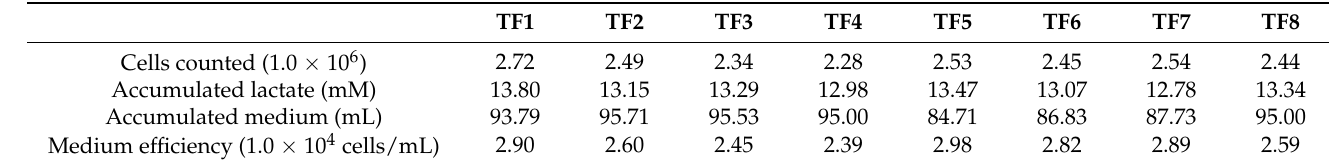
Table 6. Cell expansion results from the second controller experiment. Number of cells counted, total amount of accumulated lactate produced (mM), total amount of medium supplied (mL) and the overall medium efficiency (cells/mL).